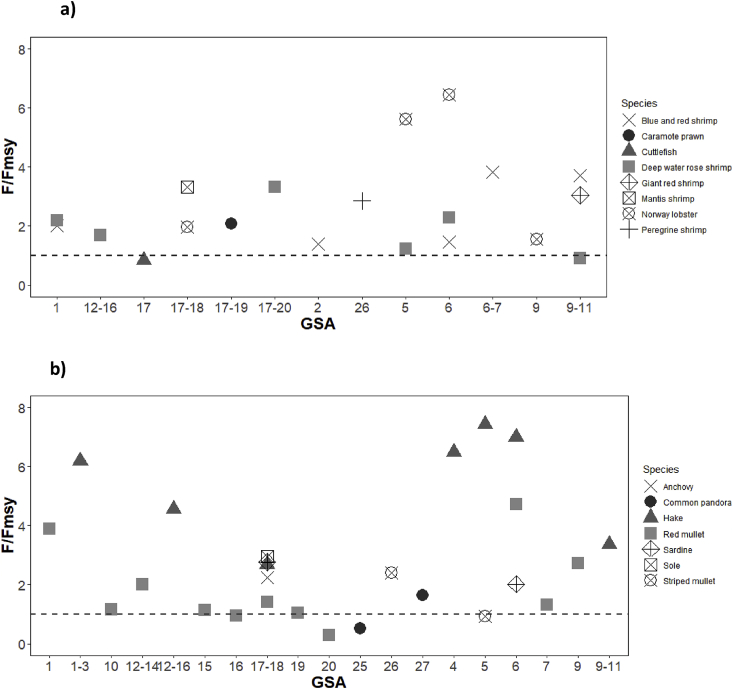
Summary of the most recent F/FMSY ratios available for Med-LME commercial stocks in the period 2017–2018: a) crustaceans and cephalopods; b) fish. The dotted line indicates sustainable fishing mortality: F/FMSY = 1. (Source: GFCM, 2018a, GFCM, 2018b; STECF, 2019).